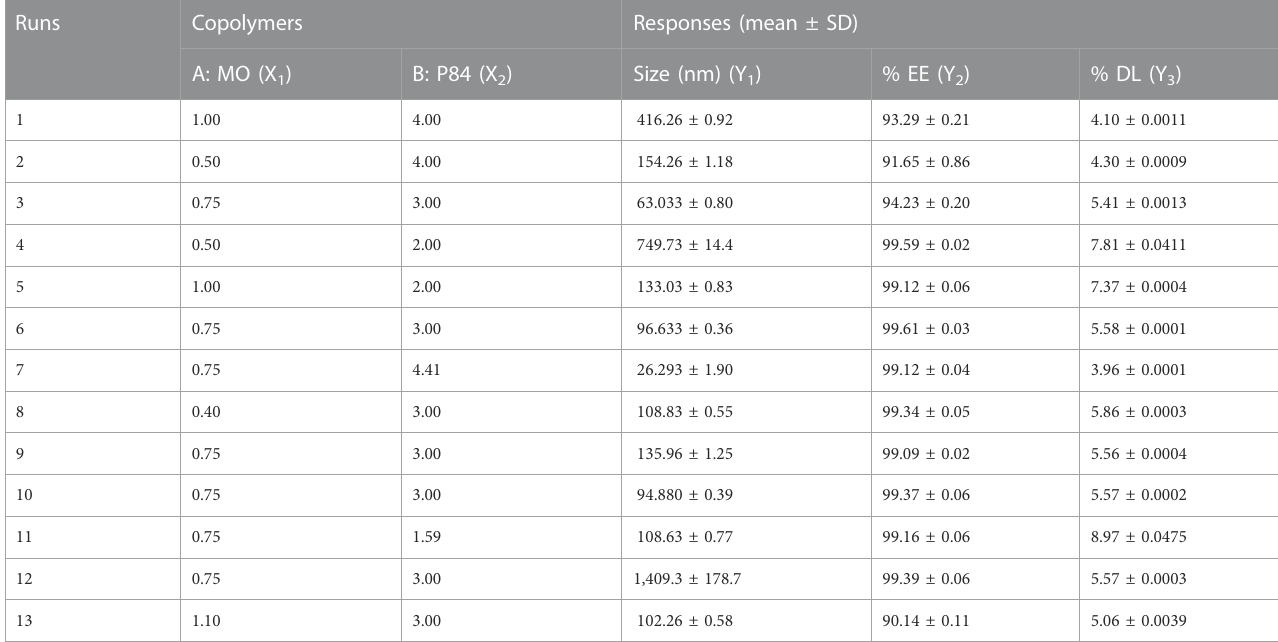
TABLE 1 Central composite design of experiment and measured responses of ER-CUB. Runs